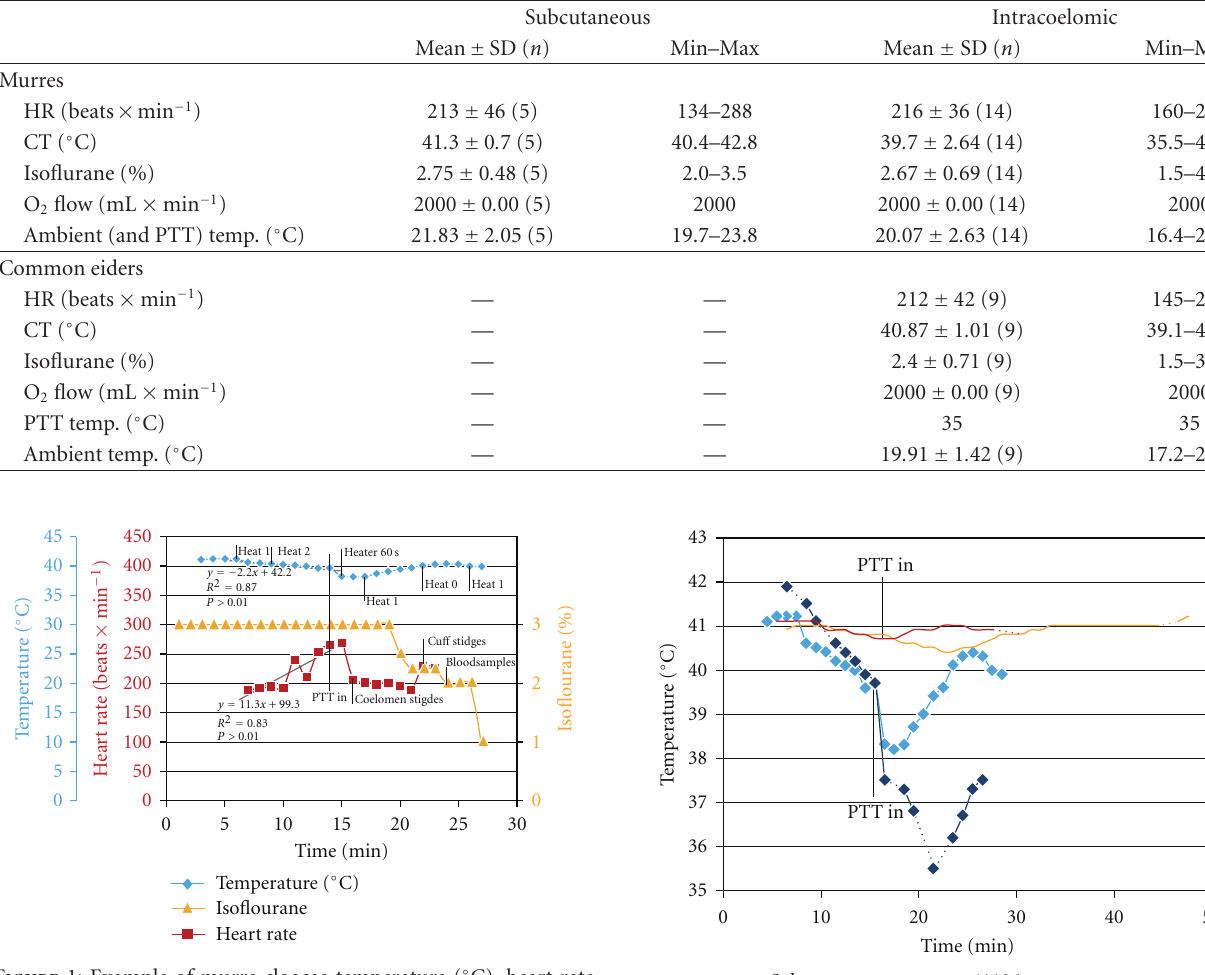
Figure 1: Example of murre cloacae temperature ( ◦ C), heart rate (beats × min − 1 ), and Isoflurane concentration (%) versus time (minutes) during intracoelomic PTT implantation (ID number 41183). Heat 1/Heat 2:heat blanket; heater: heat gun. Results from the linear regressions are added.